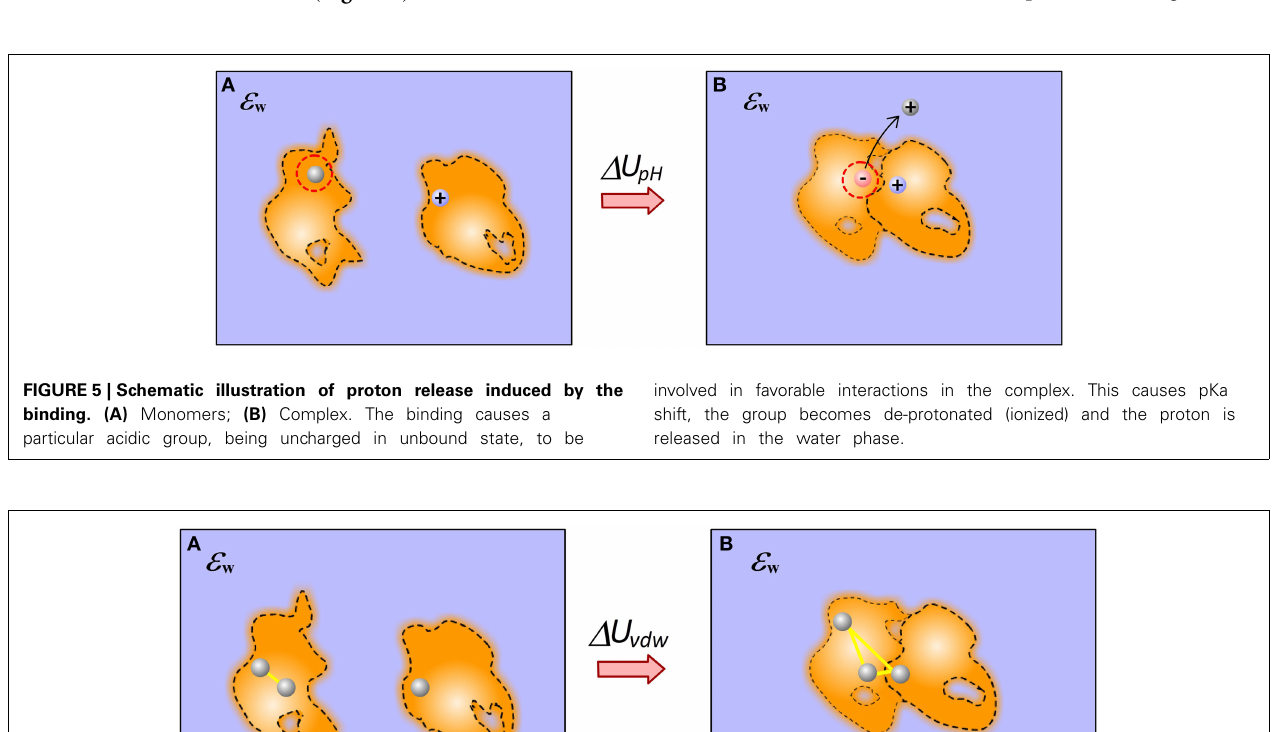
FIGURE 6 | Cartoon presentation of the vdW energy contribution to the binding. (A) Monomers; (B) Complex. In case of end-point approach with different structures for bound and unbound states, the vdW contribution has